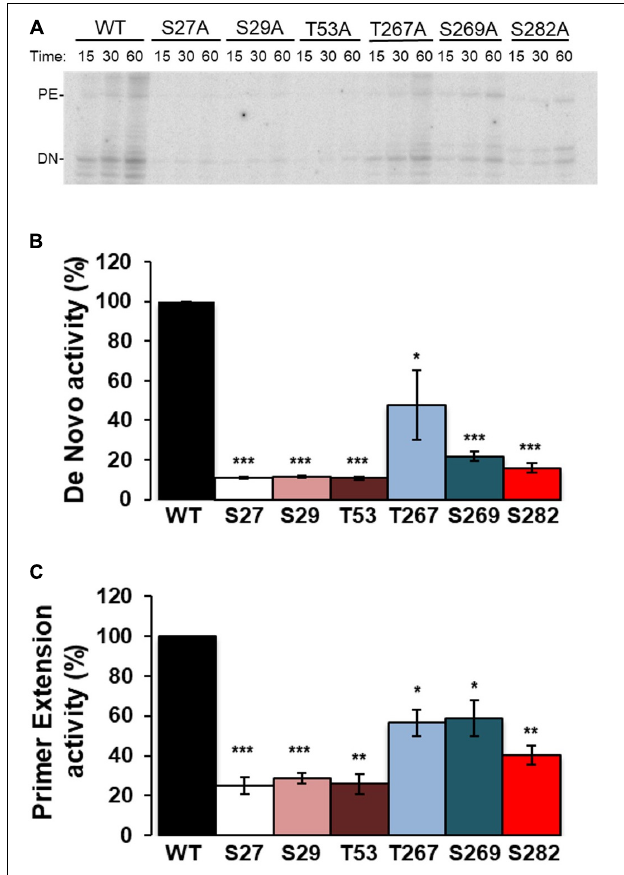
FIGURE 4 | Elongation of LE19 oligonucleotide by de novo initiation and primer extension RDRP activity of NS5B Ala mutants. NS5B WT and Ala mutants of residues S27, S29, T53, T267, S269, and S282 were assayed as described in “Materials and Methods” section. Aliquots were stopped at 15, 30, and 60 min, and resolved in denaturing polyacrylamide gels (PAA 23%). (A) Representative experiment showing products obtained by primer extension (PE) and de novo initiation (DN) using LE19 RNA as a template. Recombinant proteins used are indicated at the top. (B) RNA-dependent RNA polymerase de novo activity products at 60 min were quantified and represented in arbitrary units. (C) RNA-dependent RNA polymerase primer extension activity products at 60 min were quantified and represented in arbitrary units. The mutated residue (Ala mutant) corresponding to each bar is indicated at the bottom. Values in (B,C) are the averages (normalized to WT) and corresponding Standard Errors of the Mean (SEM) from at least four independent experiments. Statistically significant differences (Student’s t -test) are represented as follows: * p < 0.05; ** p < 0.005; *** p < 0.0005. Asterisks over the bar indicate the p -value comparing to WT.